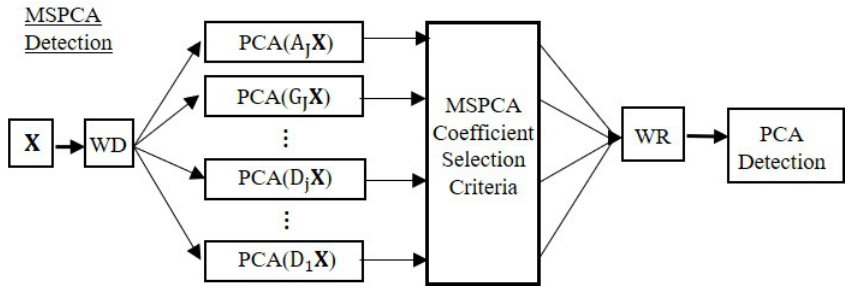
Figure 4. MSPCA fault detection algorithm.